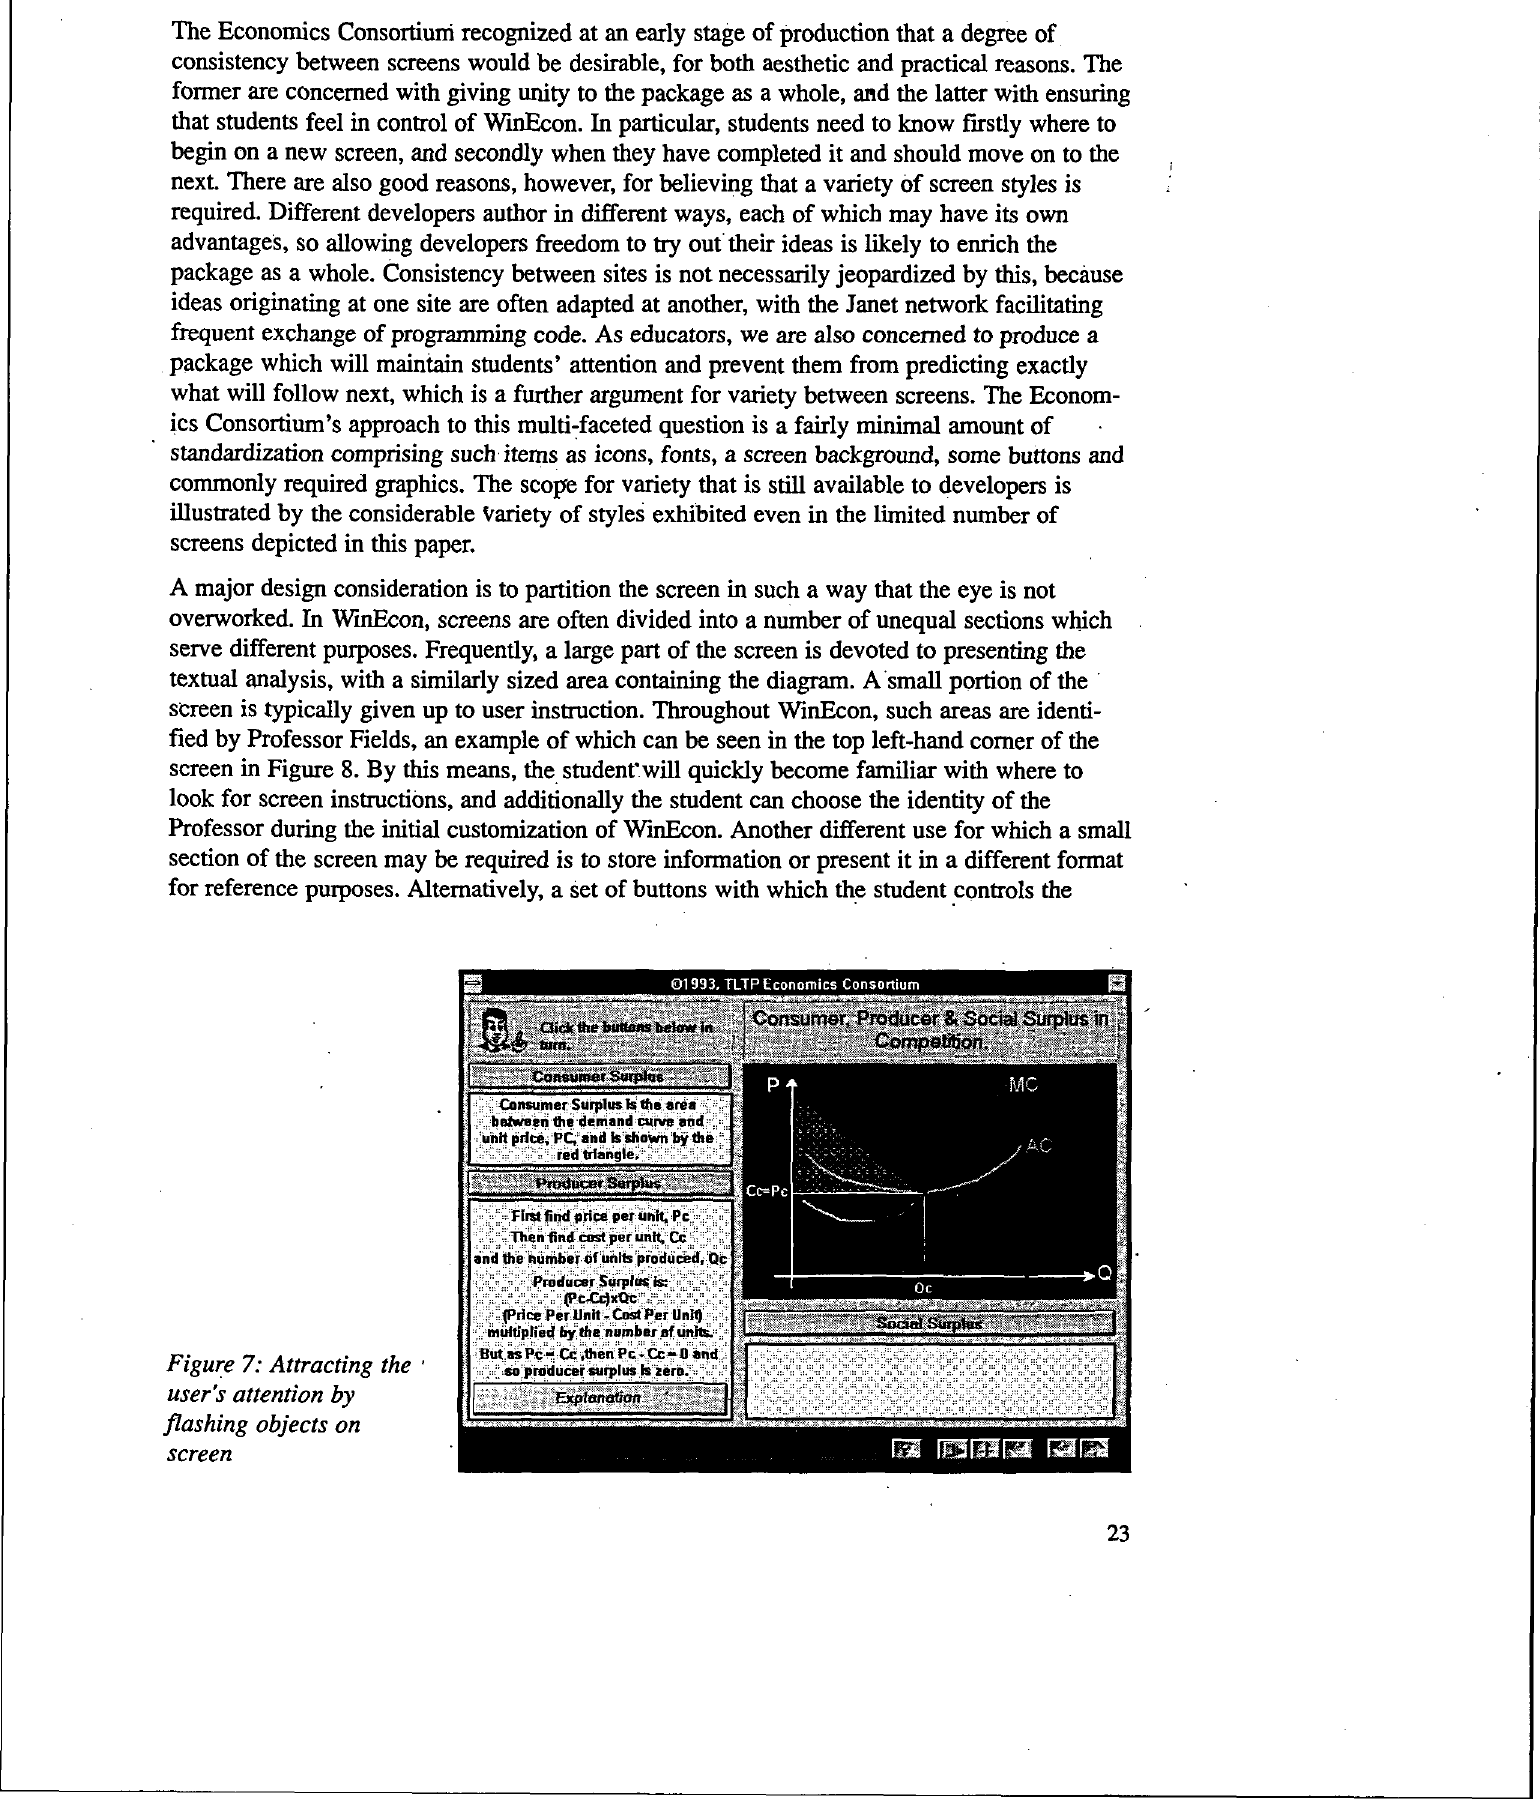
Figure 7: Attracting the user's attention by flashing objects on